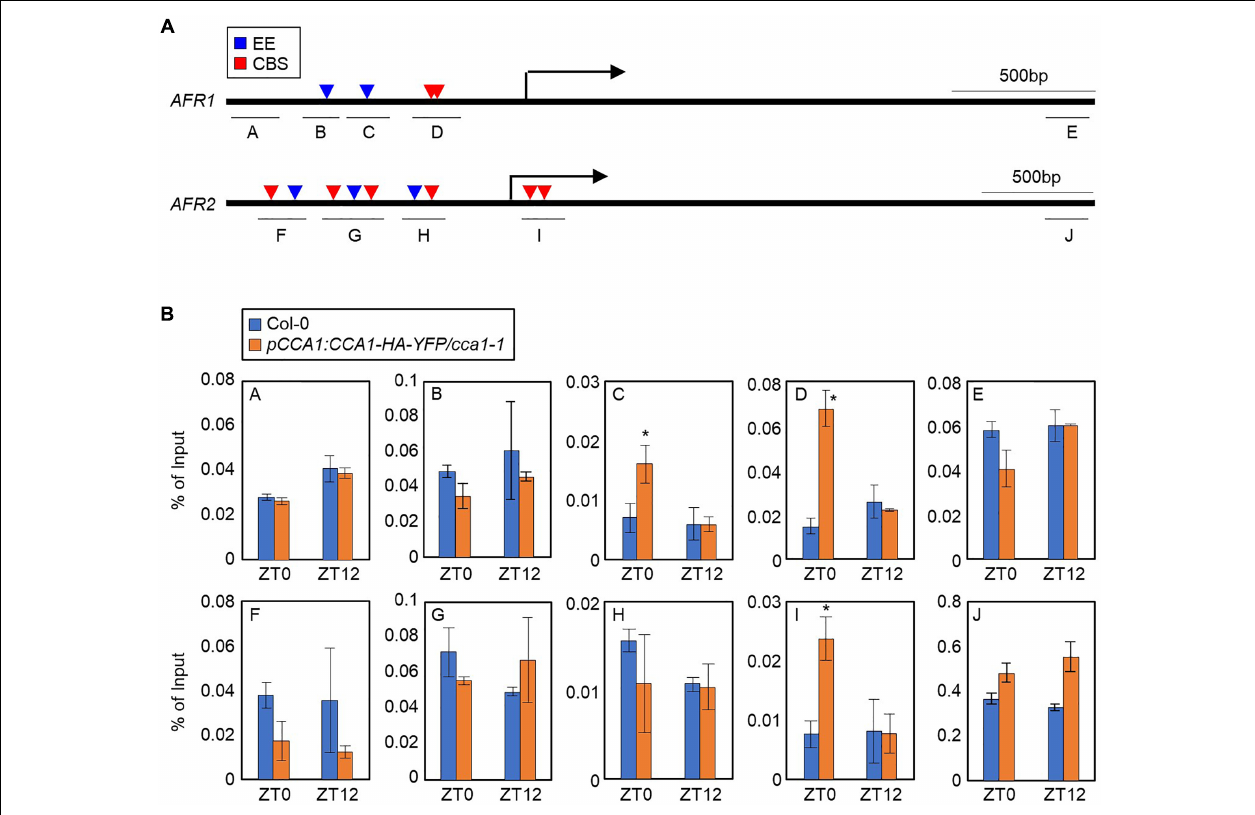
FIGURE 2 | Binding of CCA1 to AFR promoters. (A) Promoter analysis of the AFR1 and AFR2 genes. Underbars indicate the regions amplified by PCR after chromatin immunoprecipitation (ChIP). CBS, CCA1-binding site; EE, evening element. (B) Binding of CCA1 to the AFR loci. Two-week-old plants entrained with ND cycles were subjected to LL. Plants were harvested at ZT0 and ZT12 for ChIP analysis with anti-HA antibody. Three independent biological replicates were averaged, and statistically significant differences (Student’s t -test, ∗ P < 0.05) are indicated by asterisks. Bars indicate the standard error of the